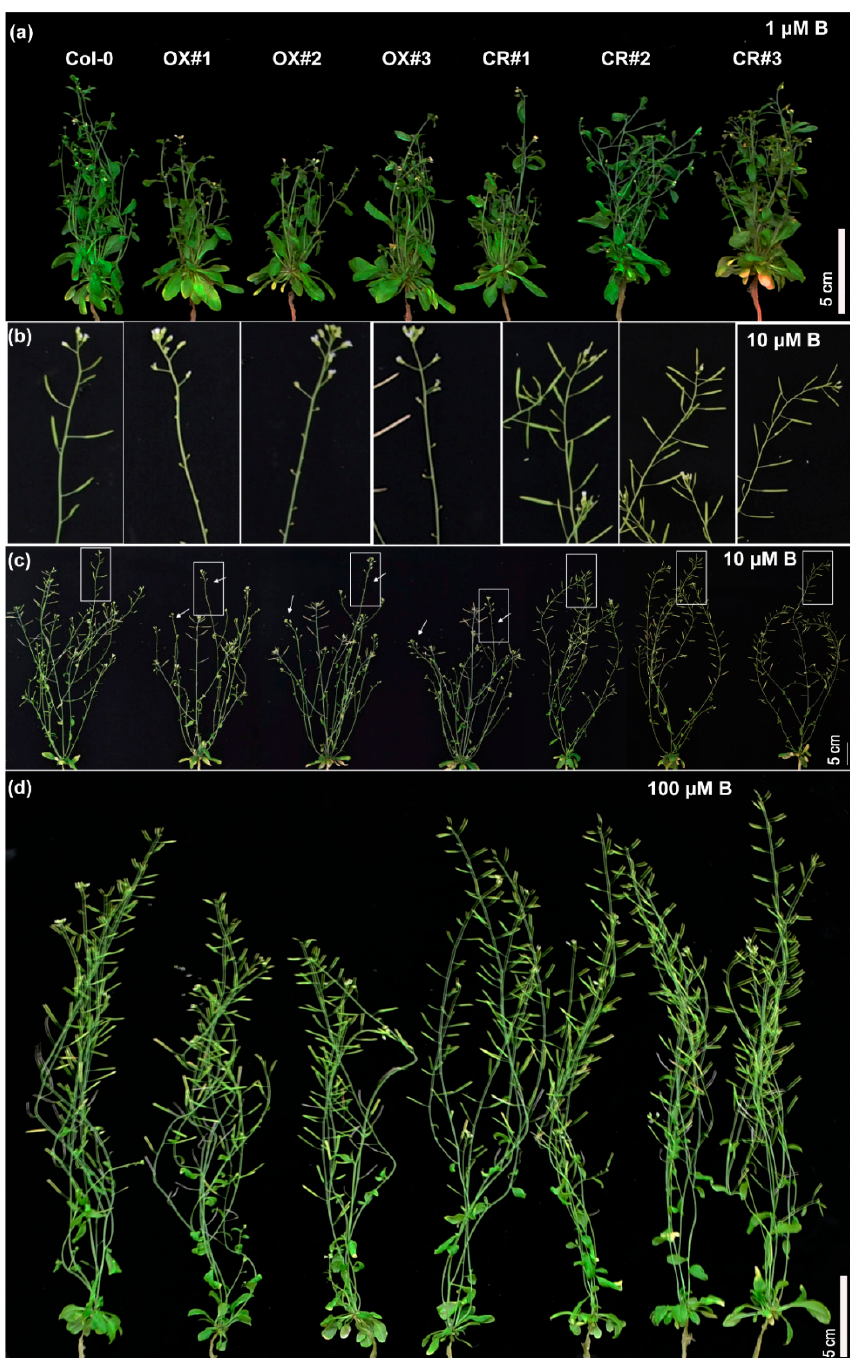
Figure 5. Phenotype response of the TCH4 transgenic lines at the maturity stage. ( a , c , d ) Phenotype of wild-type (Col-0) and TCH4 transgenic lines grown in media consisting of 1, 10, and 100 μ M B for 45 d, respectively. Scale bar, 5 cm. ( b ) Close-up views of the white box in ( c ).